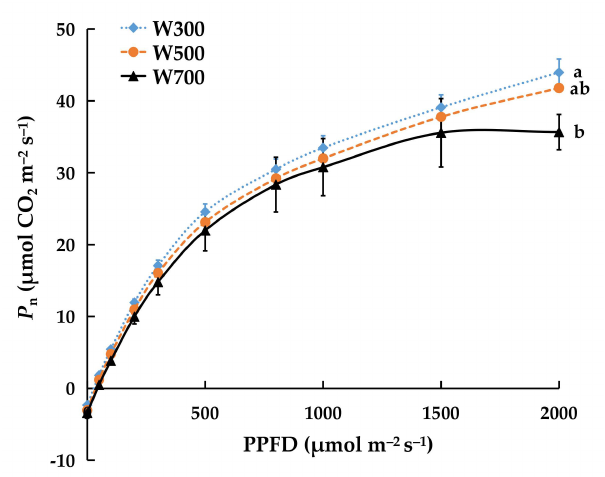
Figure 3. Light response curve of net leaf photosynthetic rate in ‘Micro-Tom’ 11 DAT in Experiment 1. The Pn to PPFD was determined on the third leaf (counted from top, fully expanded, and unshaded leaf). Each value represents the average of three plants. Error bars represent ± standard error. Different letters indicate significant differences among the treatments based on Tukey − Kramer’s test at p < 0.05. W300, W500, and W700 denote PPFDs of 300, 500, and 700 µ mol m − 2 s − 1 ,